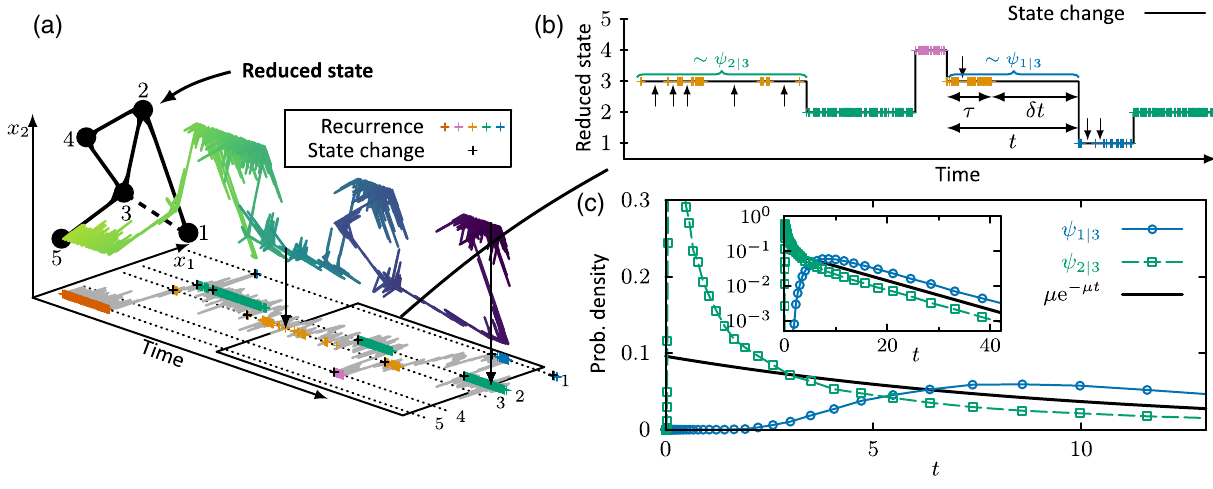
FIG. 3. Coarse-grained dynamics. (a) Projection of a trajectory of the full dynamics on the subgraph in Fig. 1(e) onto a plane (spanned by x 1 x 2 ). Time runs from bright to dark. The network is represented by black lines with each reduced state 1 ; … ; 5 . A second projection onto the x 2 ¼ 0 plane (gray line) reveals recurrences (colored crosses) and state changes (black crosses). (b) Coarse graining yields a time series of state changes (solid line); the time interval corresponds to the box in (a). One dwell interval “ τ ” and one transition-path- time interval “ δ t ” are highlighted; their sum t ¼ δ t þ τ is the local first-passage time from state i (here i ¼ 3 ) to a neighboring state j (here j ¼ 1 ). Long recurrence times are highlighted by vertical arrows. (c) Normalized probability density of local first-passage time